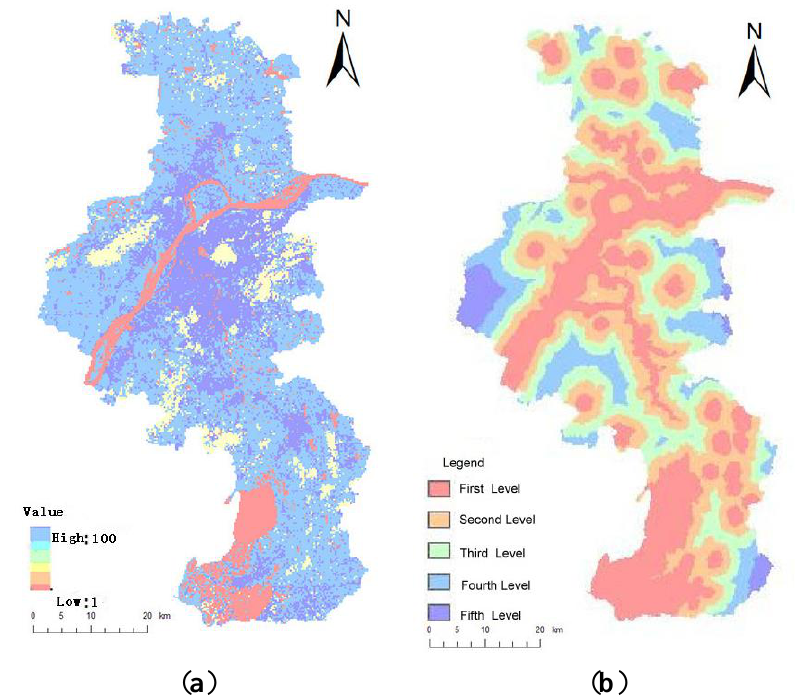
Figure 4. ( a ) Landscape resistance surface of Nanjing; and ( b ) landscape resistance trend surface of Nanjing.